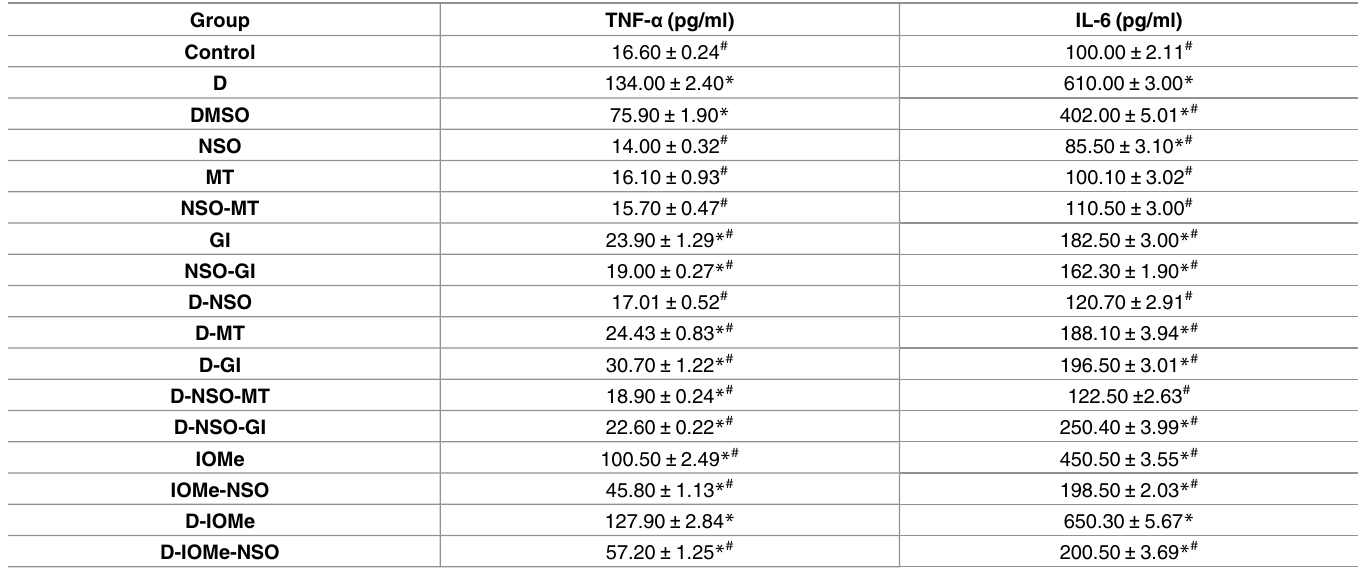
Table 4. Serum TNF- α and IL-6 levels in diabetic rats after treatment with NSO, antidiabetic drugs, combination therapy and I-OMeAG538.